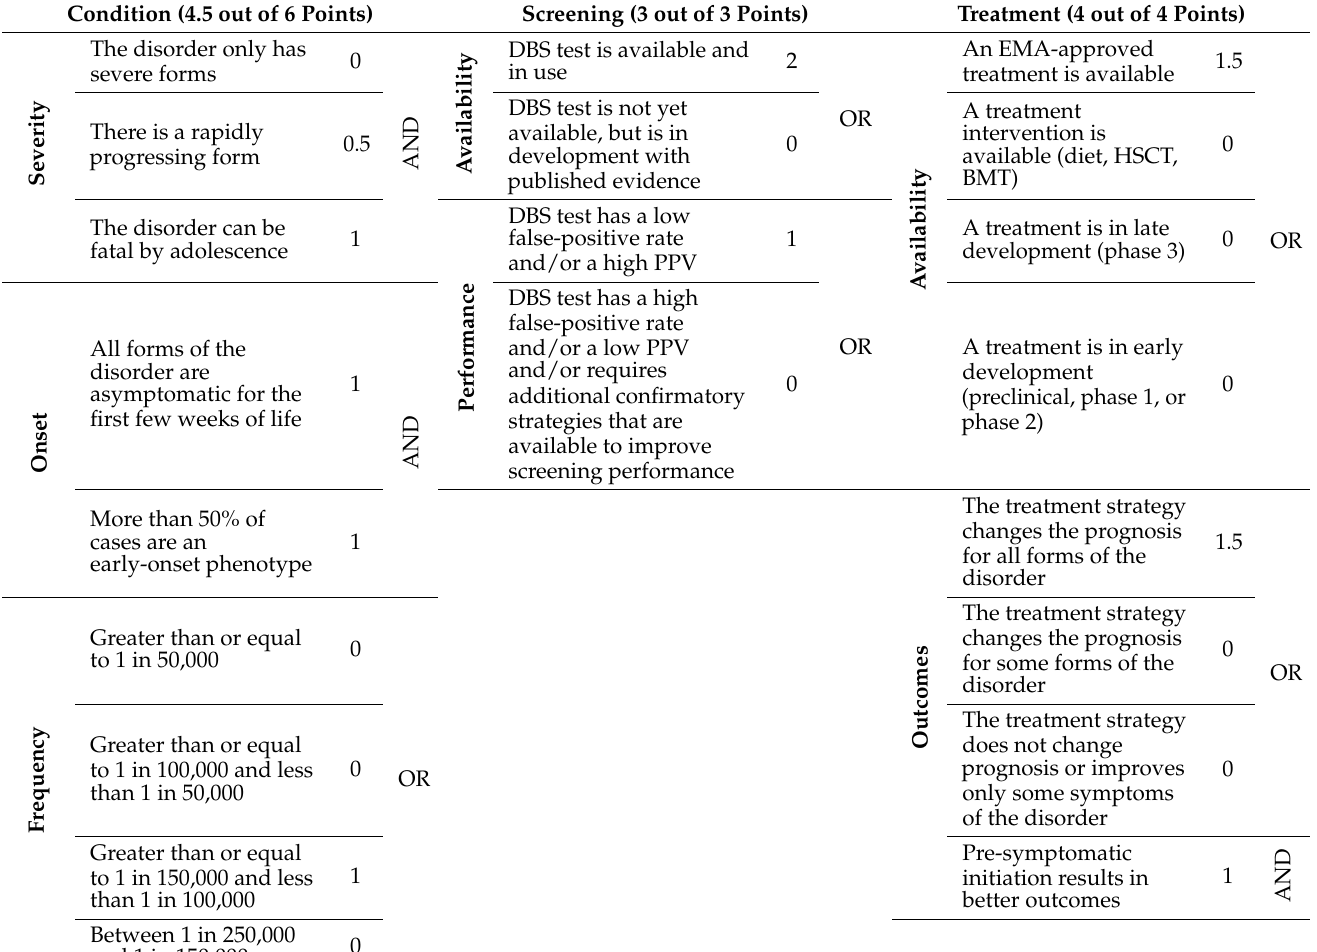
Table A3. Homocystinuria (HCU), 11.5